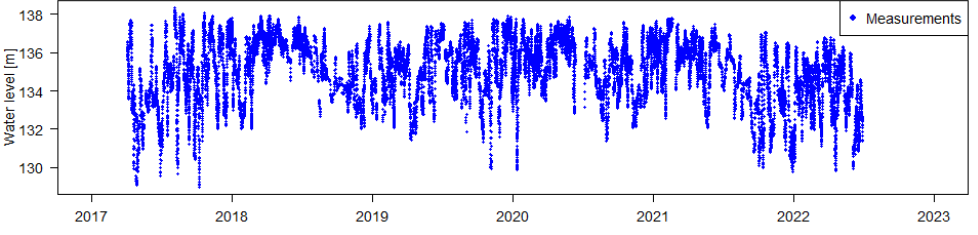
Figure 9. Time series of the reservoir water level measurements between April 2017 and June 2022.